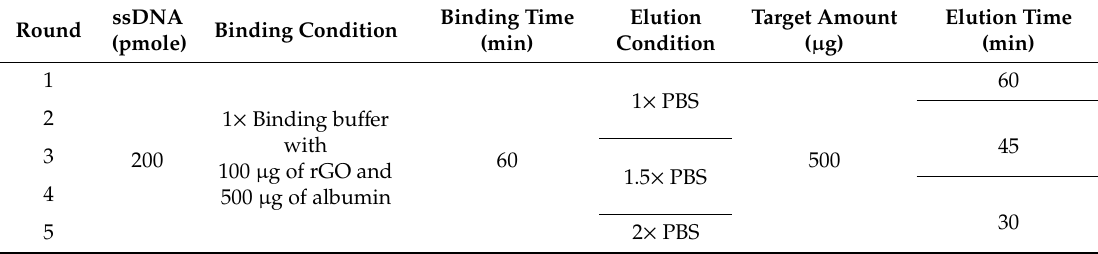
Table 1. Aptamer screening condition of each rounds with rGO-SELEX.